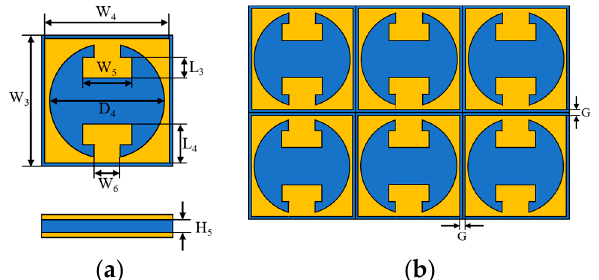
Figure 2. The AMC designs: ( a ) unit cell and ( b ) 2 × 3 structure. Table 1. The values of AMC variables (unit: mm).